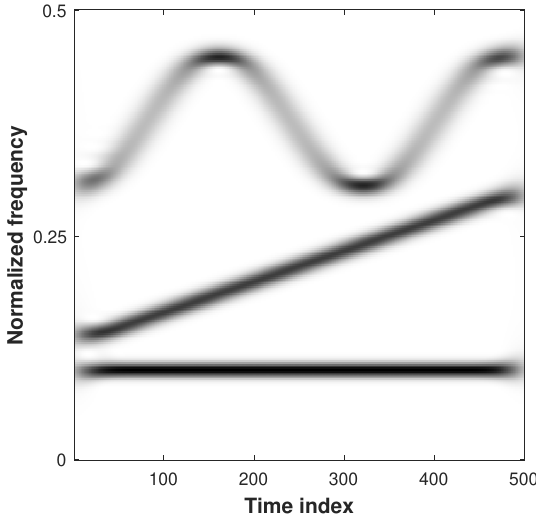
Figure 4. Spectrogram of the analyzed multicomponent